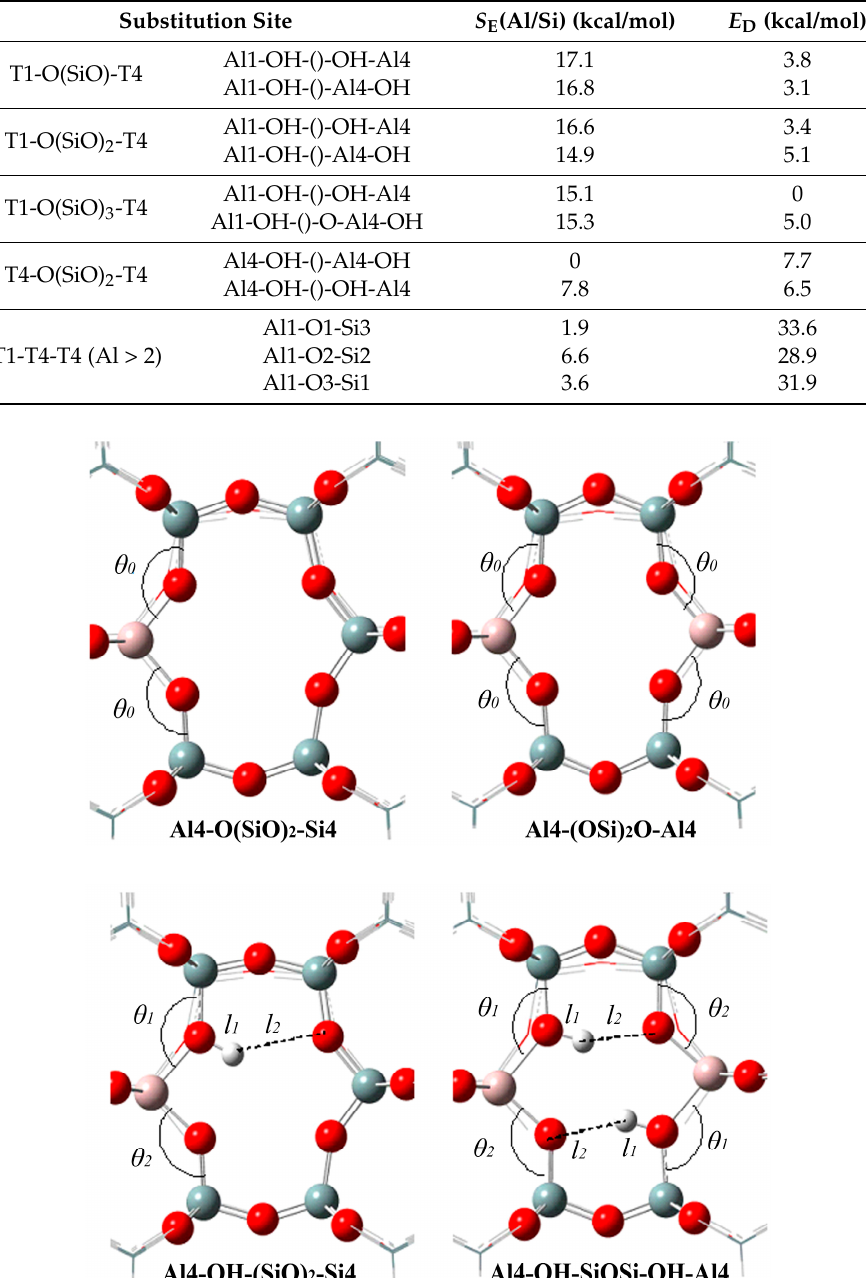
Figure 3. Location of the hydrogen bonds in Al4 ‐ O(SiO) 2 ‐ Si4 and Al4 ‐ (OSi) 2 O ‐ Al4 sites.